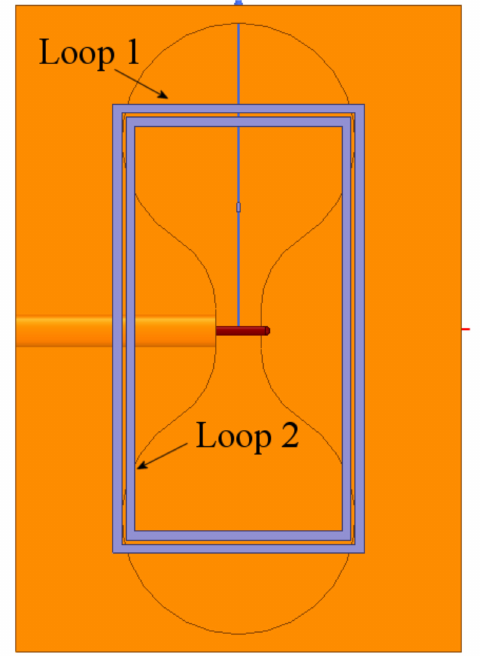
Figure 11. Loops 1 and 2 set along over the dumbbell-shaped slot and